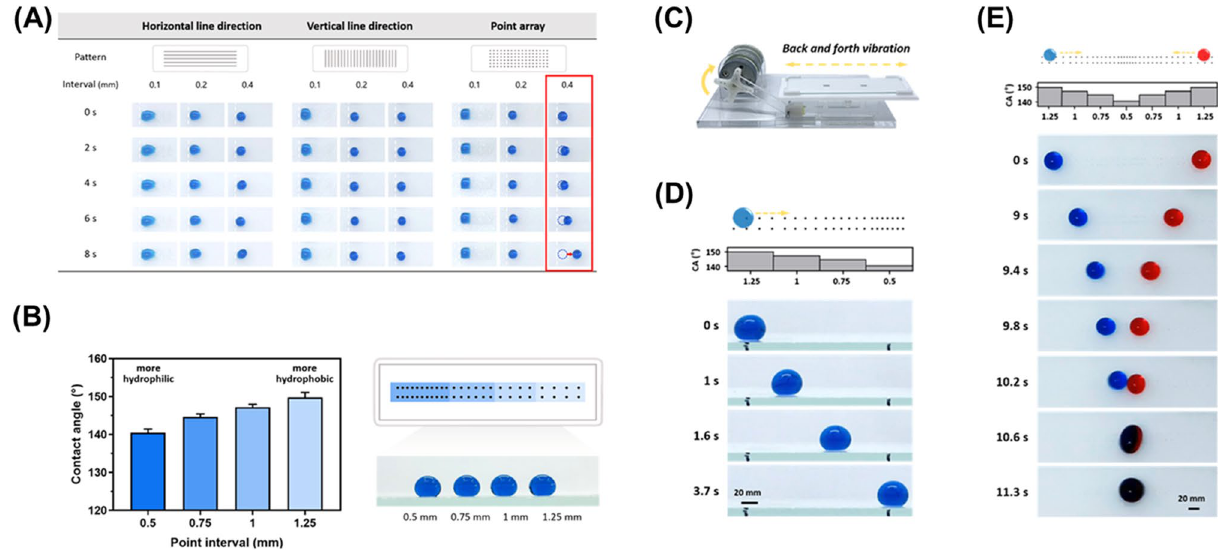
Figure 2. ( A ) Contact angle measurements with a horizontal line, vertical line, and point array. ( B ) Contact angle measurements with different intervals of point cascade (0.5, 0.75, 1, 1.25 mm). The red square indicates the optimized conditions. ( C ) The working mechanism of the droplet actuation system. ( D ) Time-lapsed images (side-view) of a 10 μL droplet transport. ( E ) Time-lapsed images (top-view) of droplets mixing with two 10 μL droplets on a mixing point cascade from opposite sides.